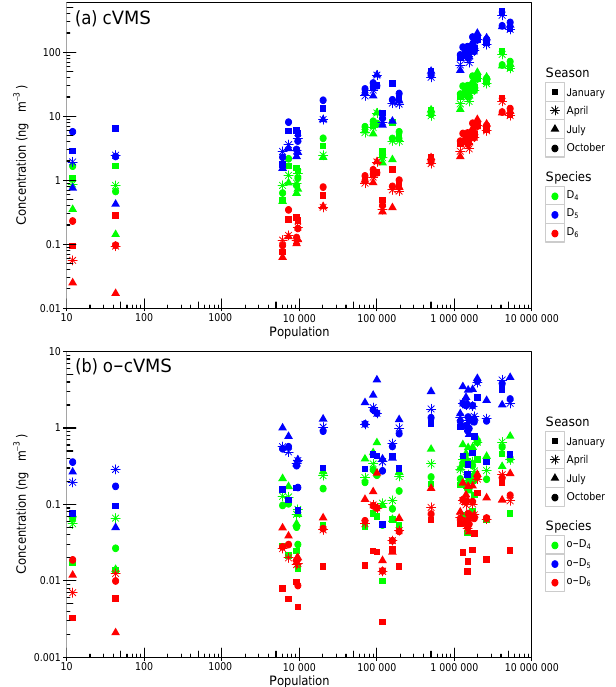
Figure 3. Average monthly CMAQ modeled surface (a ) cVMS and (b) oxidized cVMS concentrations are plotted versus 36km grid cell population for 26 US and Canadian sites. These sites include the 10 most populous US metropolitan areas, previous siloxane measure- ment sites, and NOAA Climate Monitoring and Diagnostics Labo- ratory (CMDL) sites. See Table S3 for the listing of these